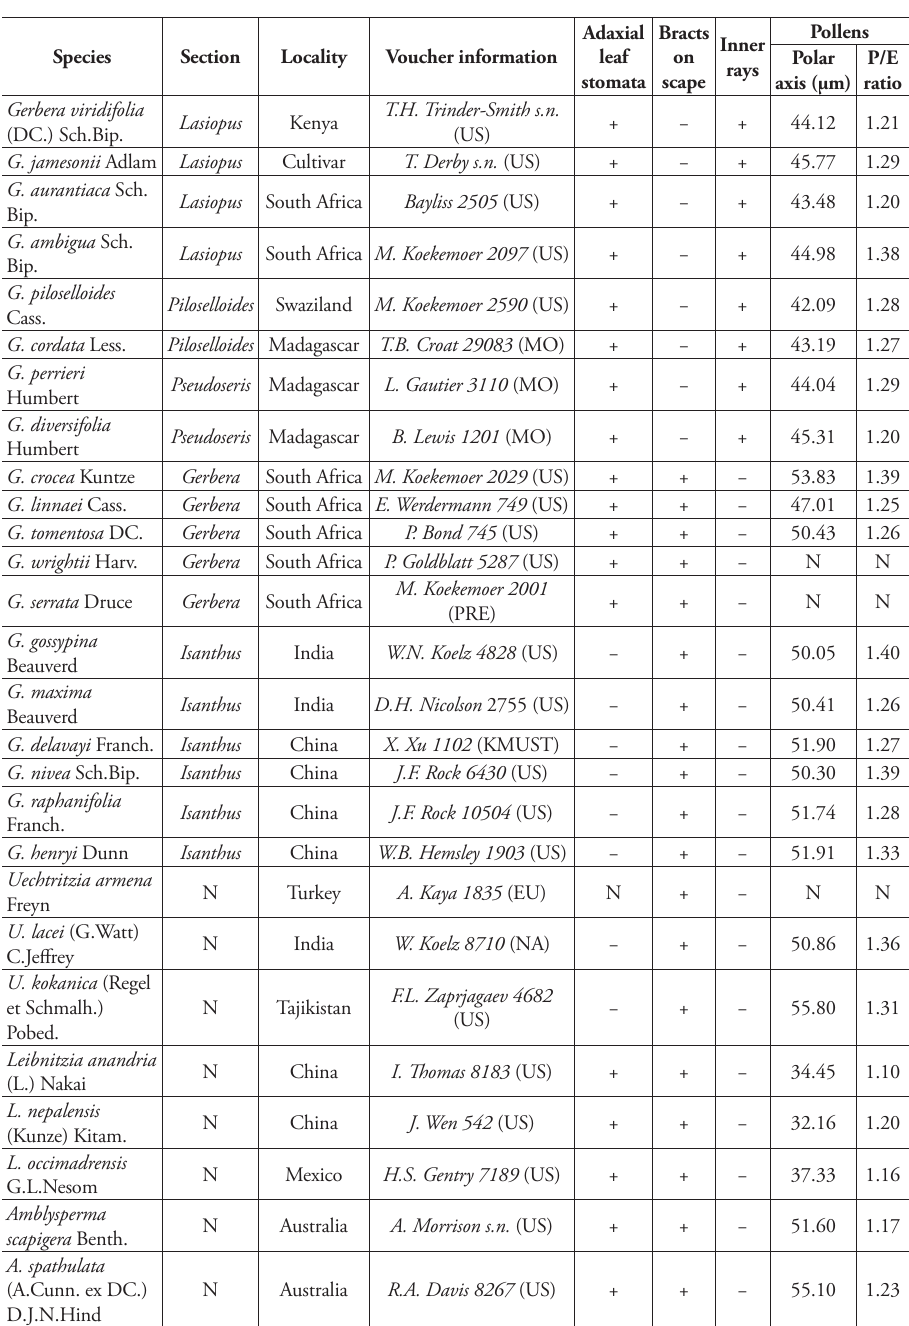
Table 1. Voucher information and morphological characters of Gerbera and related species. Species Section Gerbera viridifolia (DC.)